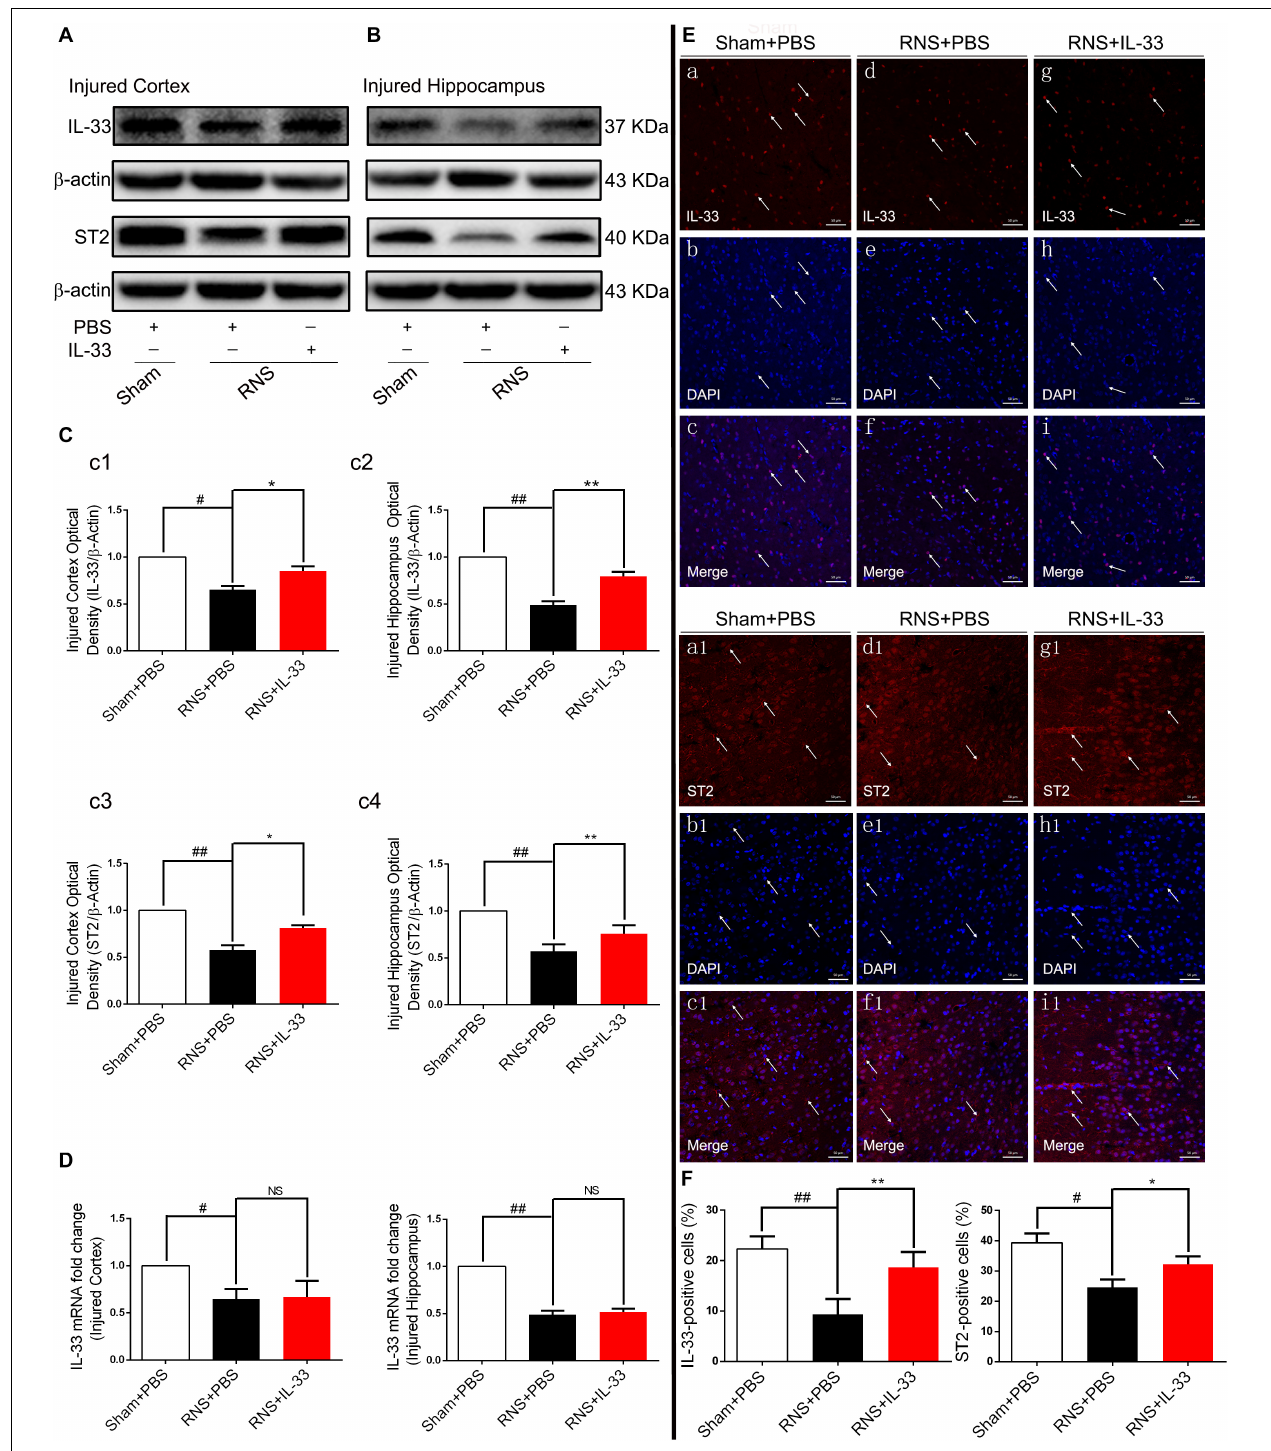
FIGURE 1 | The changes of IL-33 and ST2 expression after RNS. (A,B) RNS induced a reduction of IL-33 and ST2 expression in both cortex and hippocampus tissues. (C) The optical densities of the two types of protein bands mentioned above were quantitatively analyzed. (D) Real-time PCR analysis of IL-33 mRNA in both cortex and hippocampus tissues. (E) Immunofluorescence staining was performed to demonstrate the changes of IL-33 and ST2 expression in cortex tissue. Bar 50 µ m. (F) Semi-quantitative analysis of IL-33 or ST2 positive cells relative to the total number of cells. The data were expressed as means ± SEM ( n = 6). ## P < 0.01 vs. Sham + PBS group, # P < 0.05 vs. Sham + PBS group. ** P < 0.01 vs. RNS + PBS group, * P < 0.05 vs. RNS + PBS group. No significance (NS) was observed between RNS + IL-33 group and RNS + PBS group. Experiments are representative of three independent experiments.